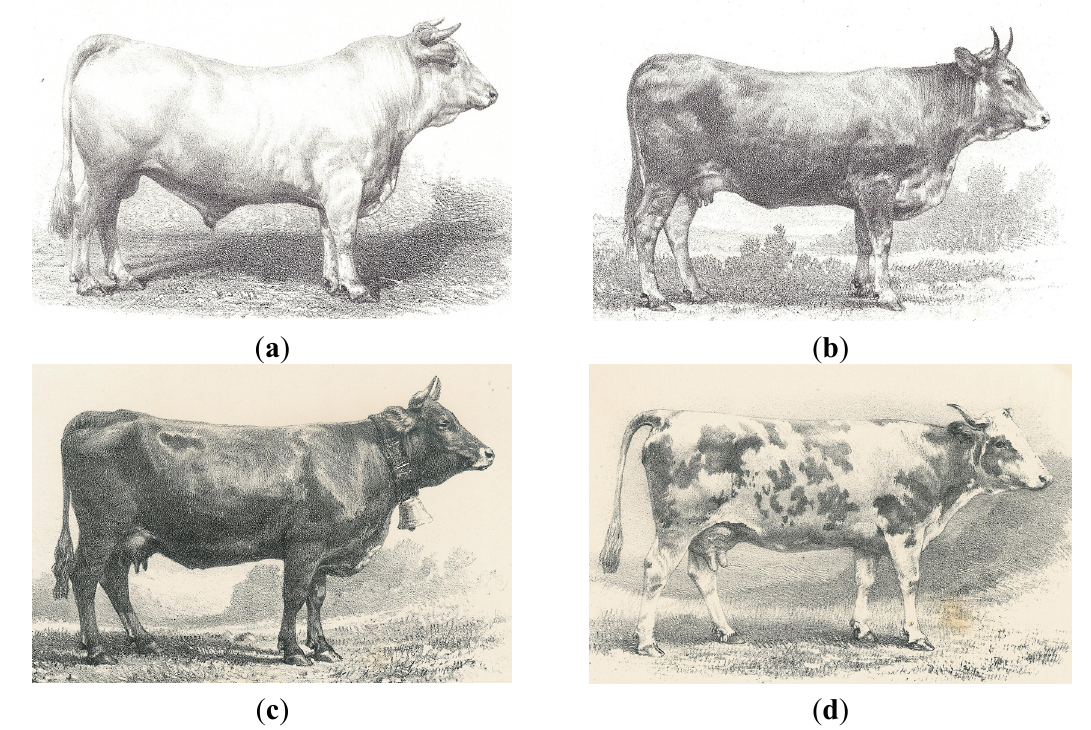
Figure 16. Central-European breeds in the 19th century [142] . ( a ) Charolais bull; ( b )